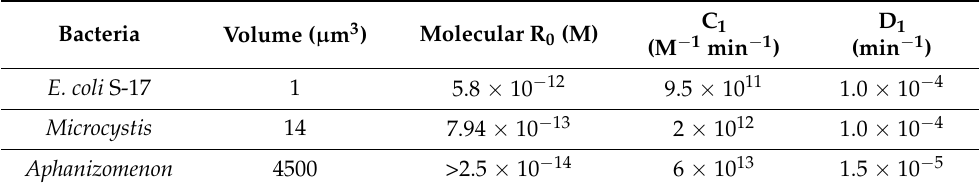
Table 8. Parameter values for convection and adsorption/desorption model which best describe the results of the filtration experiments for laboratory cultures of Microcystis, Aphanizomenon, and E. coli